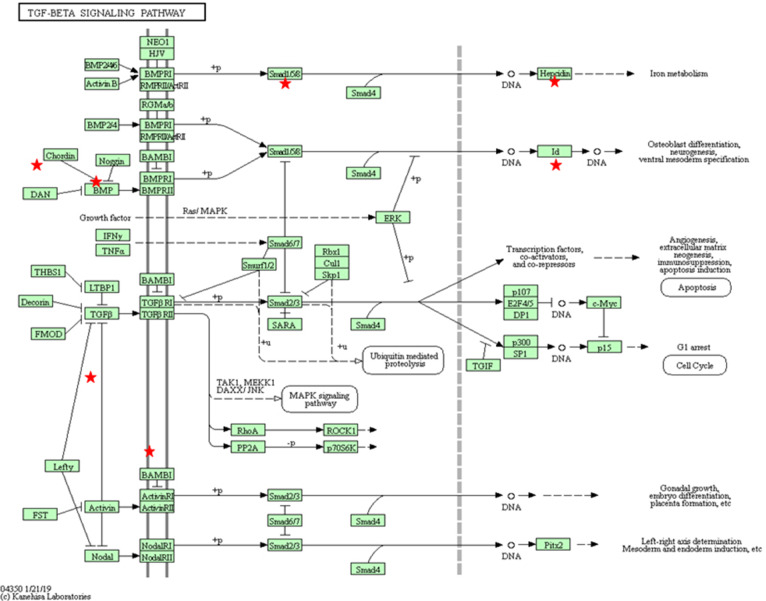
KEGG pathway for TGF-β (bta04350) with the annotated DEGs in our results between Besnoitia besnoiti-infected BAEC cells at 32 hpi vs. non-infected BAEC cells (Kanehisa, 2019). Red stars represent DEGs in the pathway: Mothers against decapentaplegic homolog 9 (SMAD9); Activin A receptor type 1C (ACVR1C); Inhibin beta E subunit (INHBE); Inhibitor of DNA binding 1 (ID1); ID2; ID3; latent transforming growth factor beta binding protein 1 (LTBP1); thrombospondin 1 (THBS1); v-myc avian myelocytomatosis viral oncogene homolog (MYC).